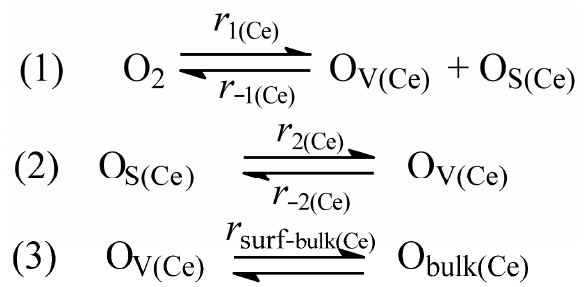
13 of 23 Figure 4. XRD patterns of MeO x /CeO 2 (Me = Fe, Co, Ni) samples. Me concentration—0.86–0.91 wt.%. We estimated the values of R I and R II on MeO x normalized to their concentration ( R I (Me,Ce) and R II (Me,Ce) , respectively) using Me/Ce values on the surface as measured with XPS and supposing overall concentration of active sites as 1.67 × 10 5 mole/m 2 . Then S values and rates of reactions of stages 1 and 2 (Scheme 1) for isotope exchange on different sites (( r 1 = r − 1 ) (Me,Ce) and ( r 2 = r − 2 )( Me,Ce) ) were calculated as well using Equations (27)–(29) (Table 5). Table 5. Me/Ce (Me = Ni, Fe, Co) atomic ratios in the surface layers (XPS) of different MeO x /CeO 2 samples, normalized rates of isotope exchange on MeOx and CeO 2 ( R I (Me,Ce) and R II (Me,Ce) ) and rates of reactions of stages 1 and 2 (Scheme 1) of isotope exchange on different sites (( r 1 = r − 1 ) (Me,Ce) and ( r 2 = r − 2 ) (Me,Ce) ). Me concentration—0.86–0.91 wt.%.